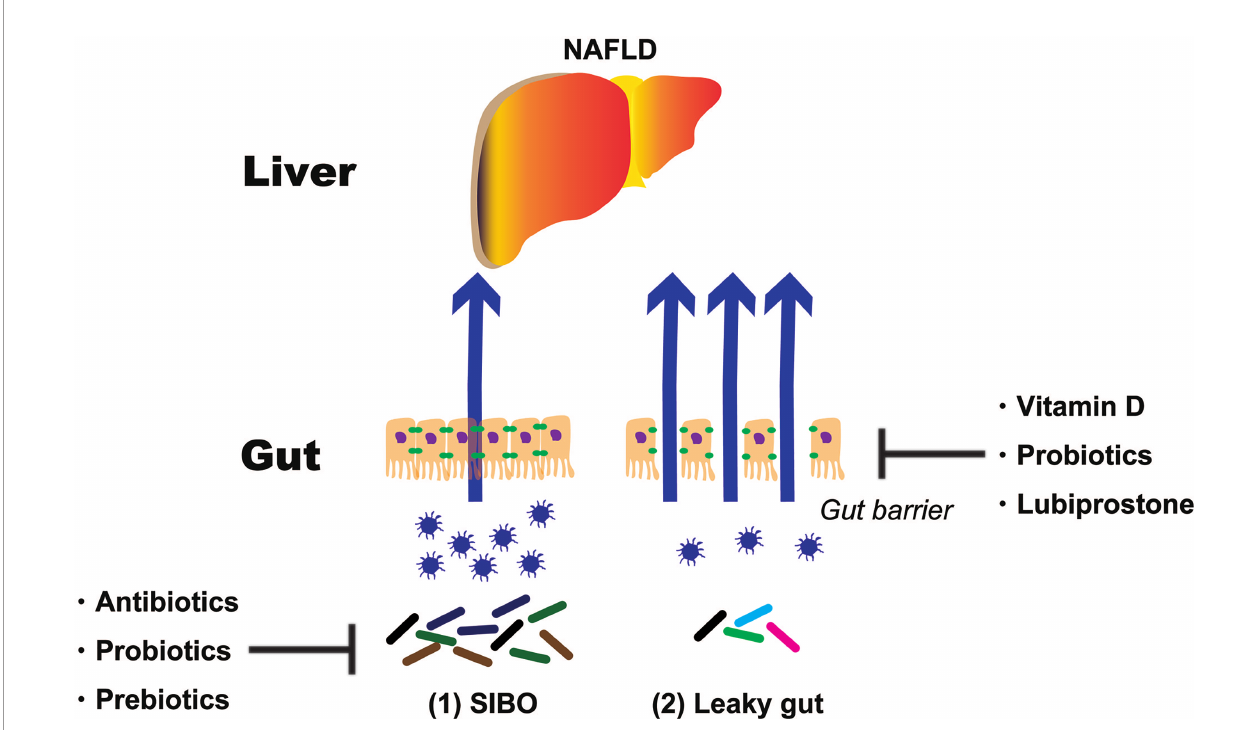
FIGURE 2 | Treatment strategies targeting the intestinal tract of NAFLD patients. NAFLD, non-alcoholic fatty liver disease; SIBO, small intestinal bacterial